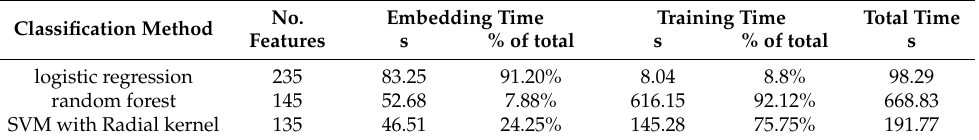
Table 11. The processing time for embedding and training (all classification combined with FastText